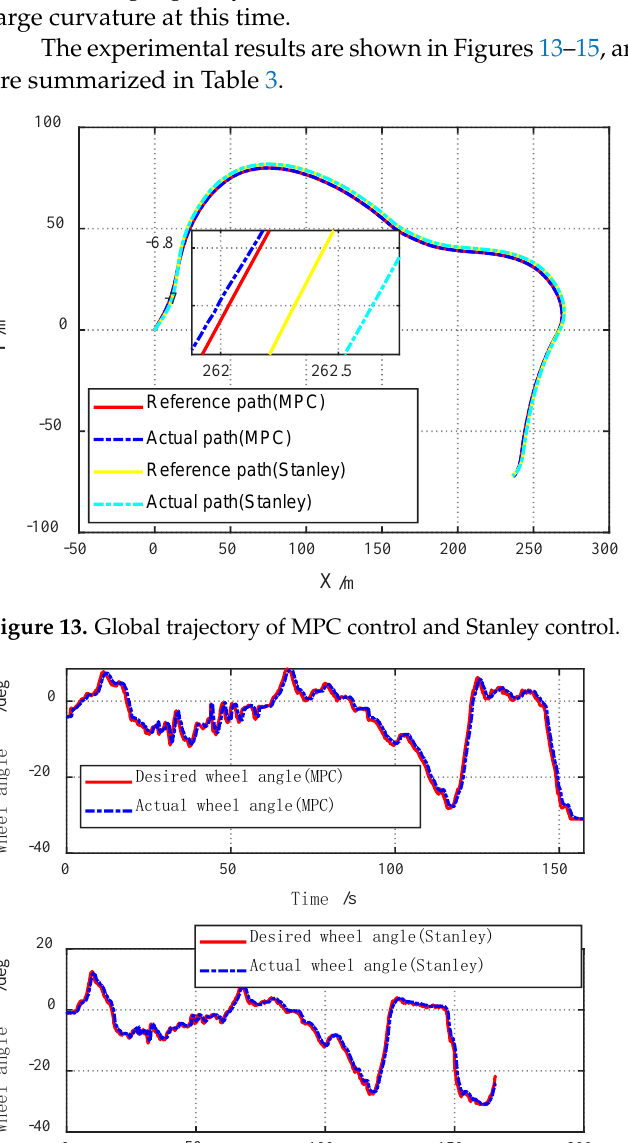
Table 3. Lateral error test results.